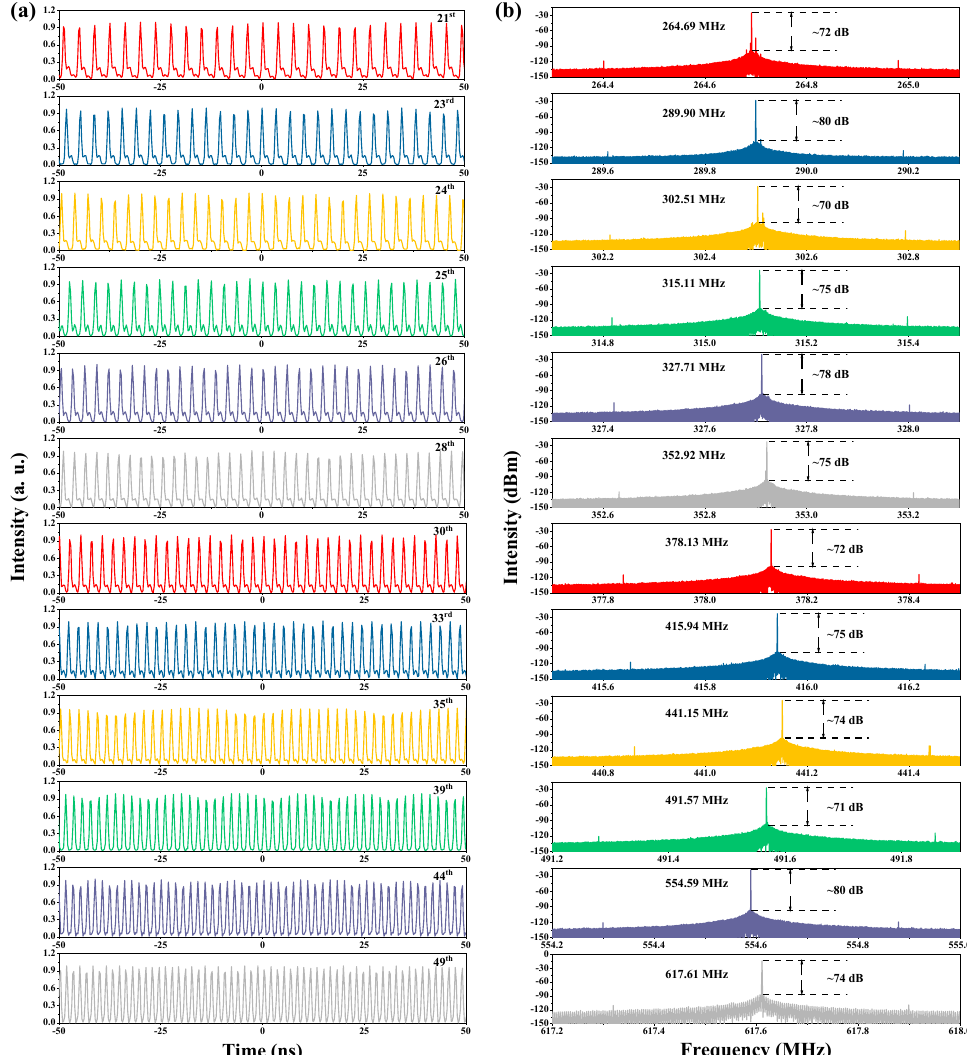
Figure 8. ( a ) Pulse trains from 21st – 49th, ( b ) corresponding RF spectra.